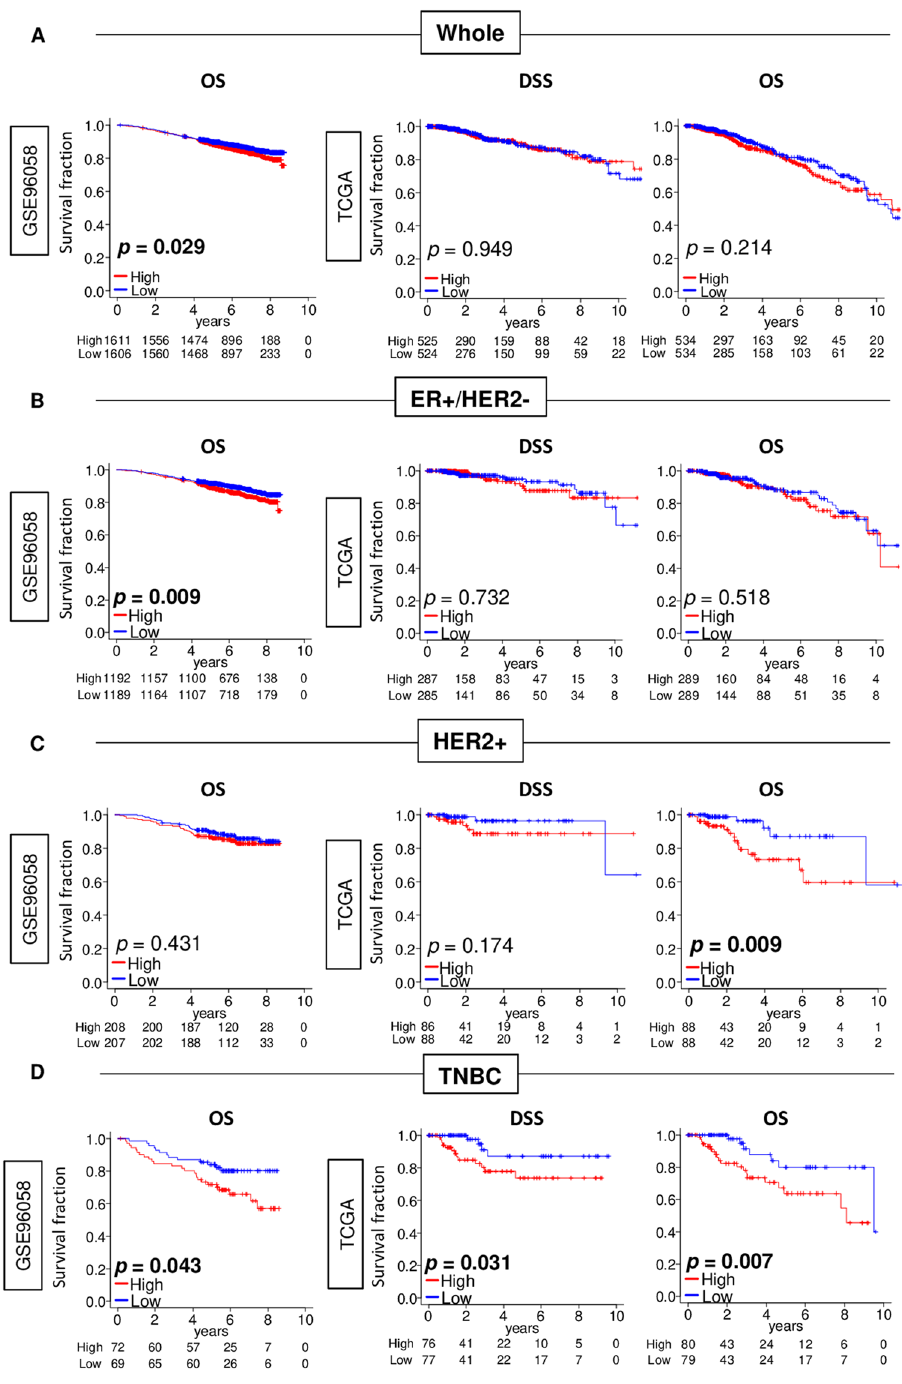
Figure 3. Association of adipogenesis pathway score with patient survival by whole and each subtype in the GSE96058 and TCGA cohorts. Kaplan–Meier plots of Disease-specific survival (DSS) in the TCGA cohort, and overall survival (OS) in both cohorts by adipogenesis low (blue) and high (red) score with (A) whole, (B) Estrogen receptor (ER)+/HER2−, (C) human epidermal growth factor receptor 2 (HER2)-positive, or (D) Triple negative breast cancer (TNBC) patients. Median value was used as the cut-off to divide into low and high adipogenesis score groups within each cohort. P -value was calculated using log-rank